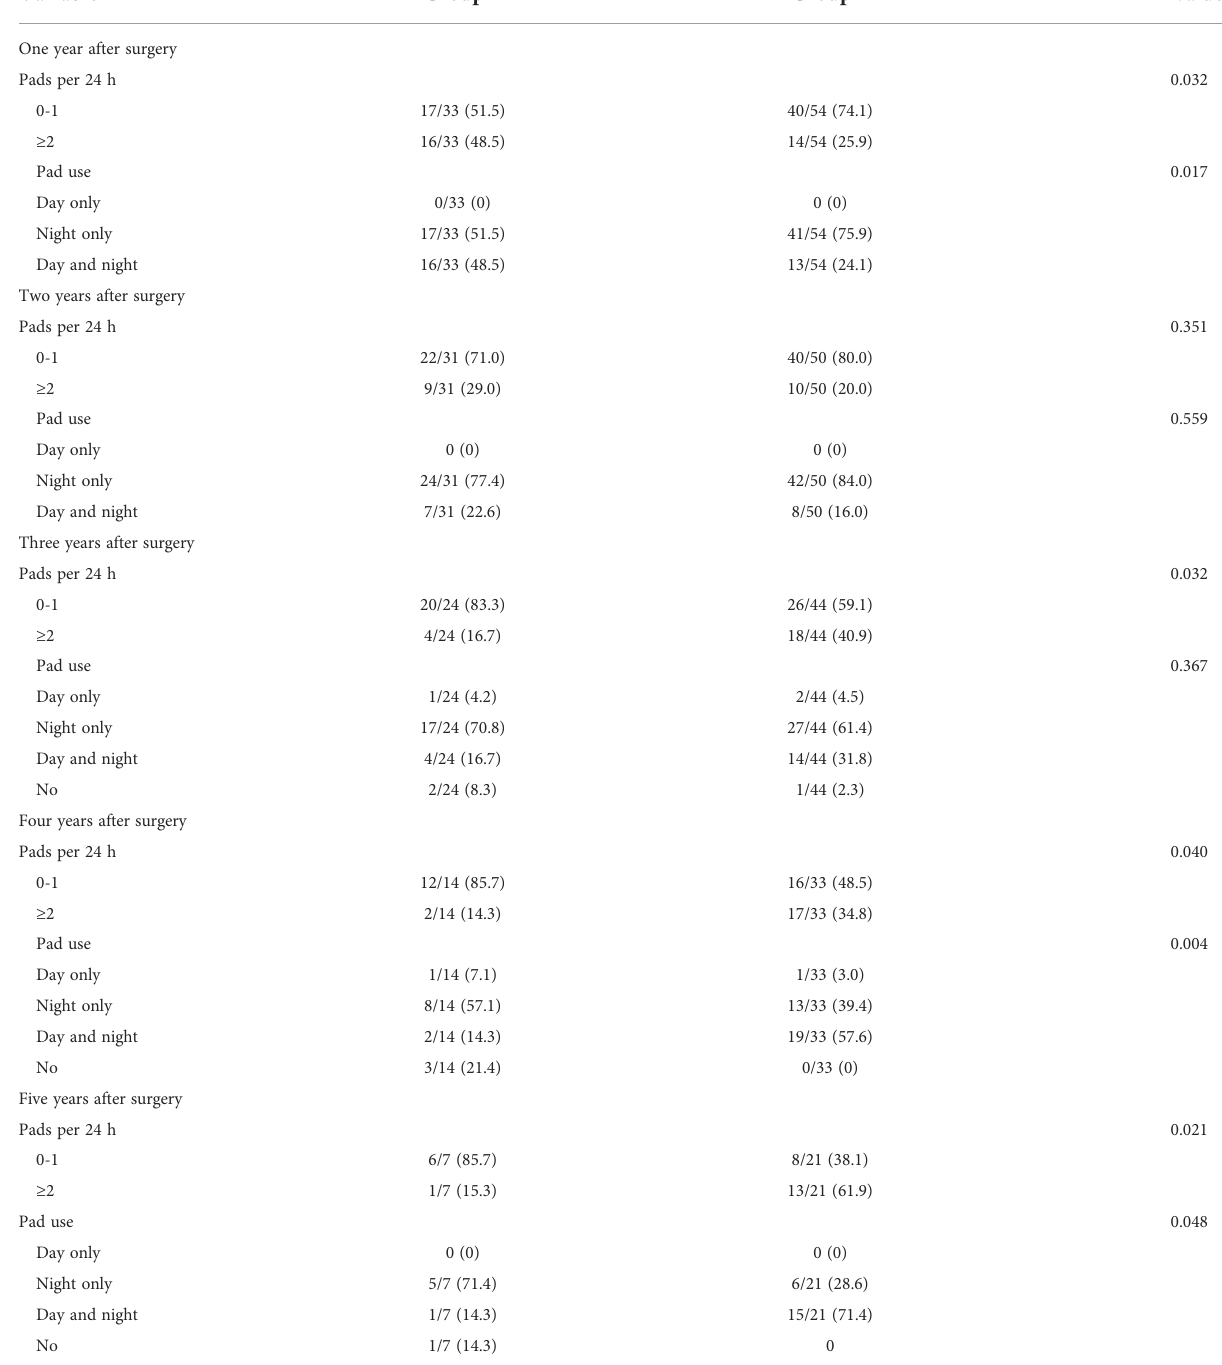
TABLE 3 The use of changing pads by